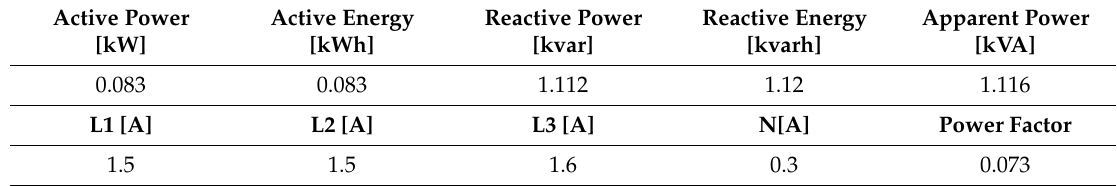
Table 4. Standby measurements result of the charging point Efacec Q45.